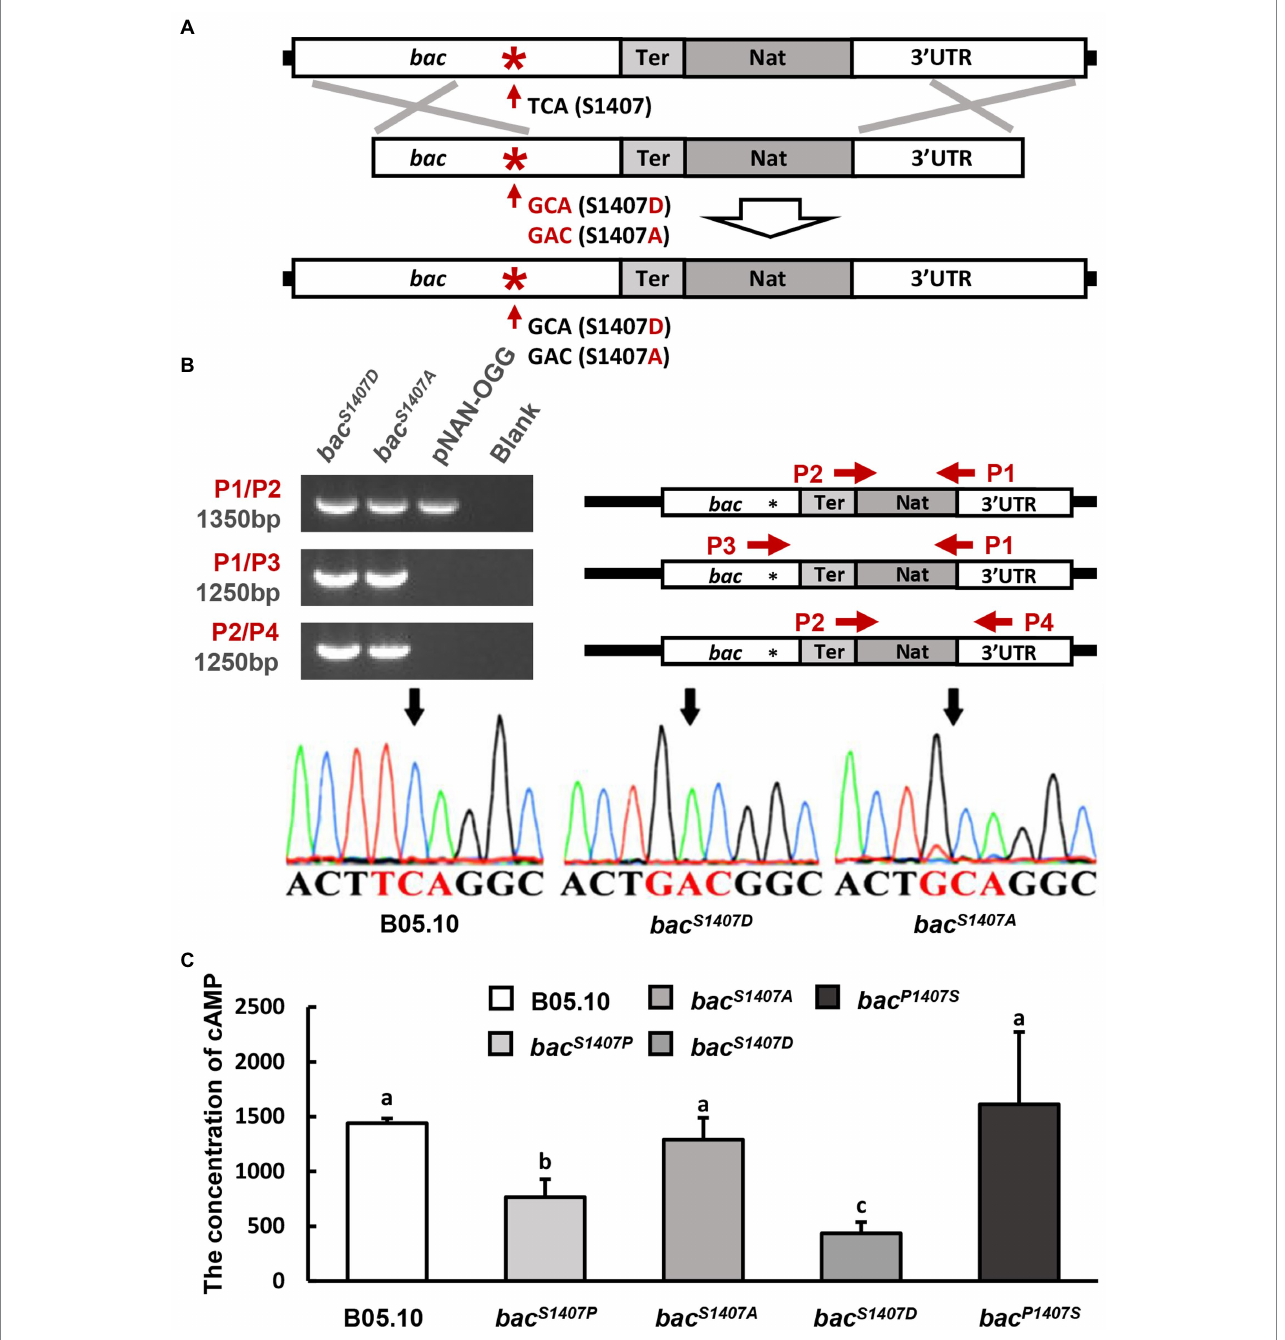
FIGURE 1 (A) Schematic representation of the in situ point mutation strategy. (B) PCR amplification of target sequences ( bac S1407D and bac S1407A ) by different primer sets (right), and electrophoretic identification of the target sequences (left). (C) Intracellular levels of cAMP in the wild type (B05.10), mutant strain ( bac S1407P , bac S1407A , bac S1407D , and bac P1407S ) observed after incubation on CM for 3 days under conditions involving light. The different letters on the columns indicate significant differences at p < 0.05. The bars present mean values ± SD ( n =